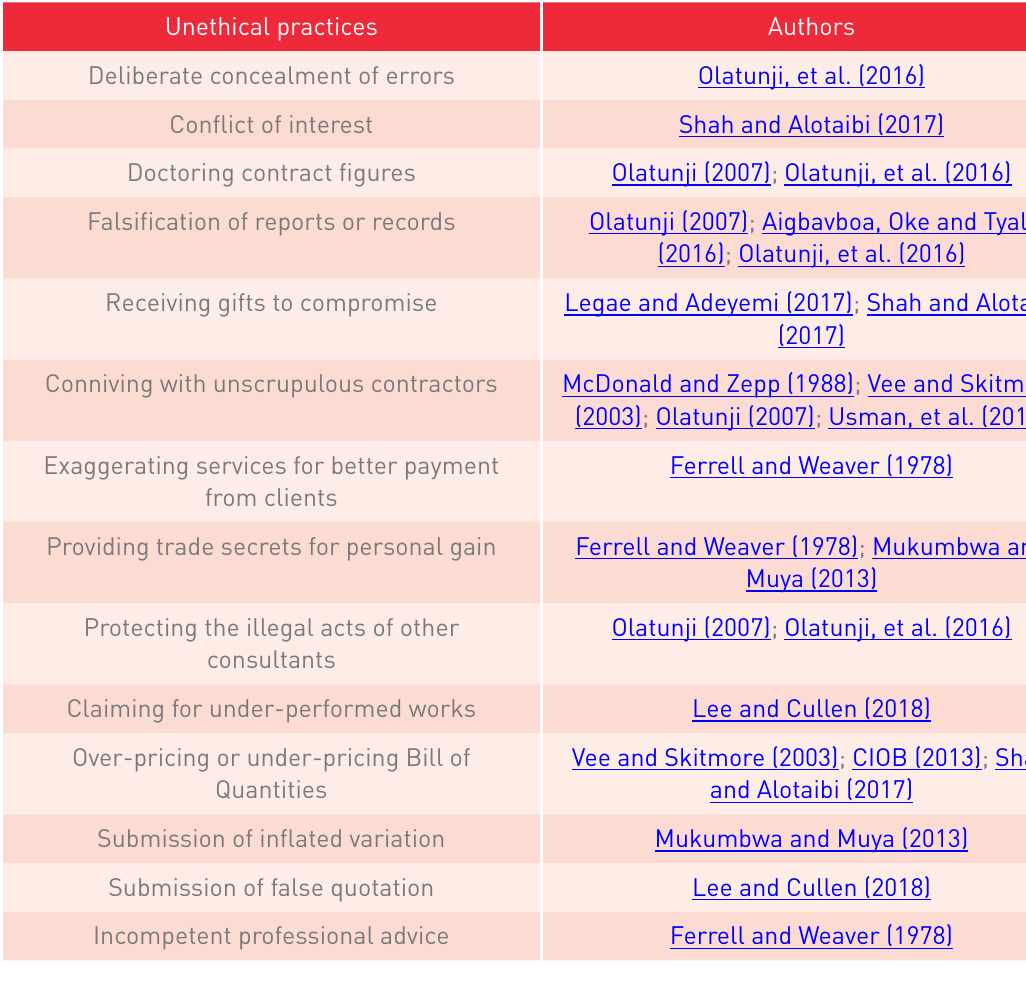
Unethical practices of QS Unethical